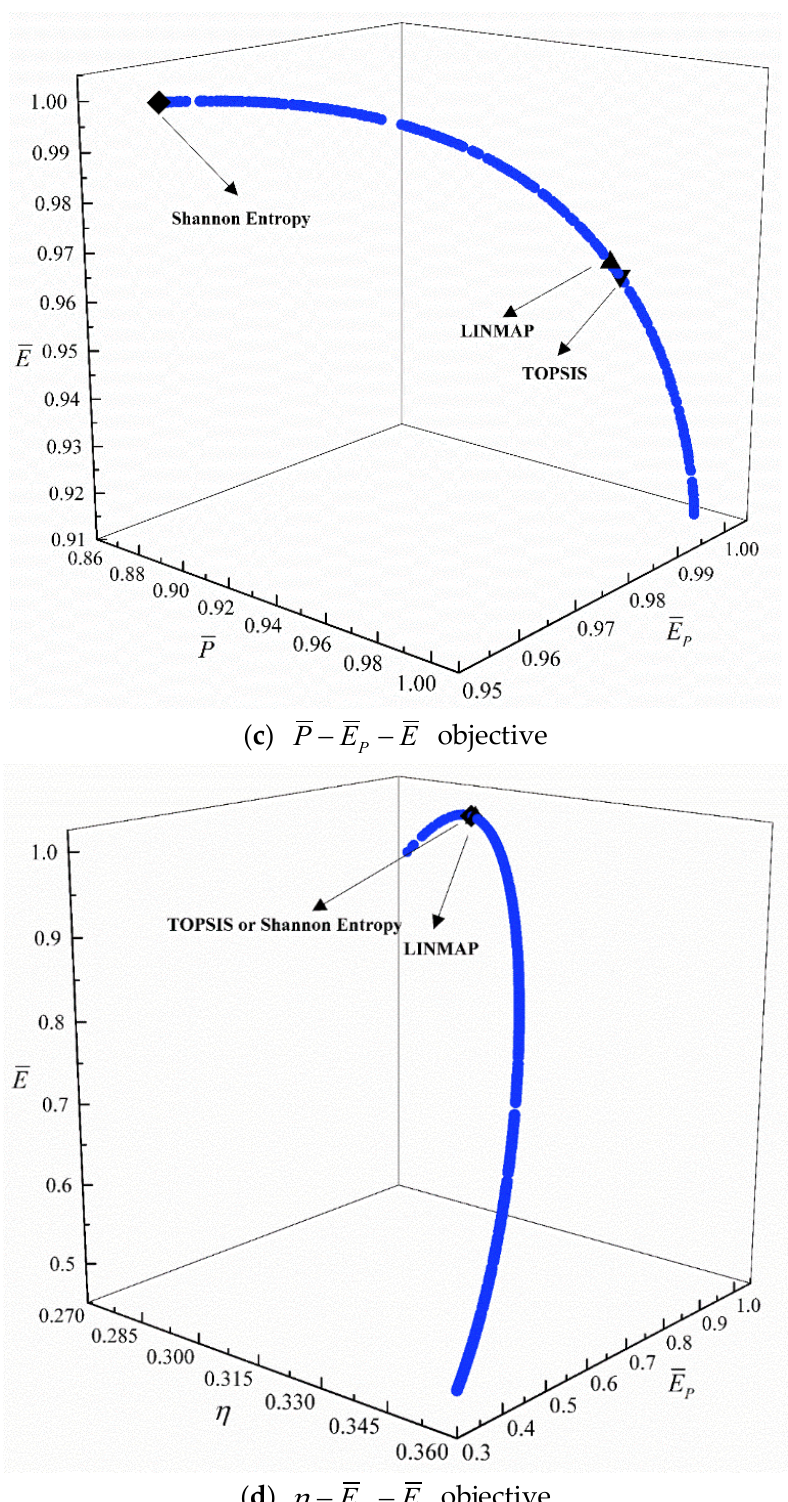
Figure 6. Pareto frontier for four tri-objective optimizations. From Appendix B, for the MOO of P − η − E and P − E P − E , the D with the LINMAP approach is better. For the MOO of P − η − E P , the D with the TOPSIS approach is better. For the MOO of η − E P − E , the D s with the Shannon Entropy and TOPSIS approaches are the same, which is less than that with the LINMAP